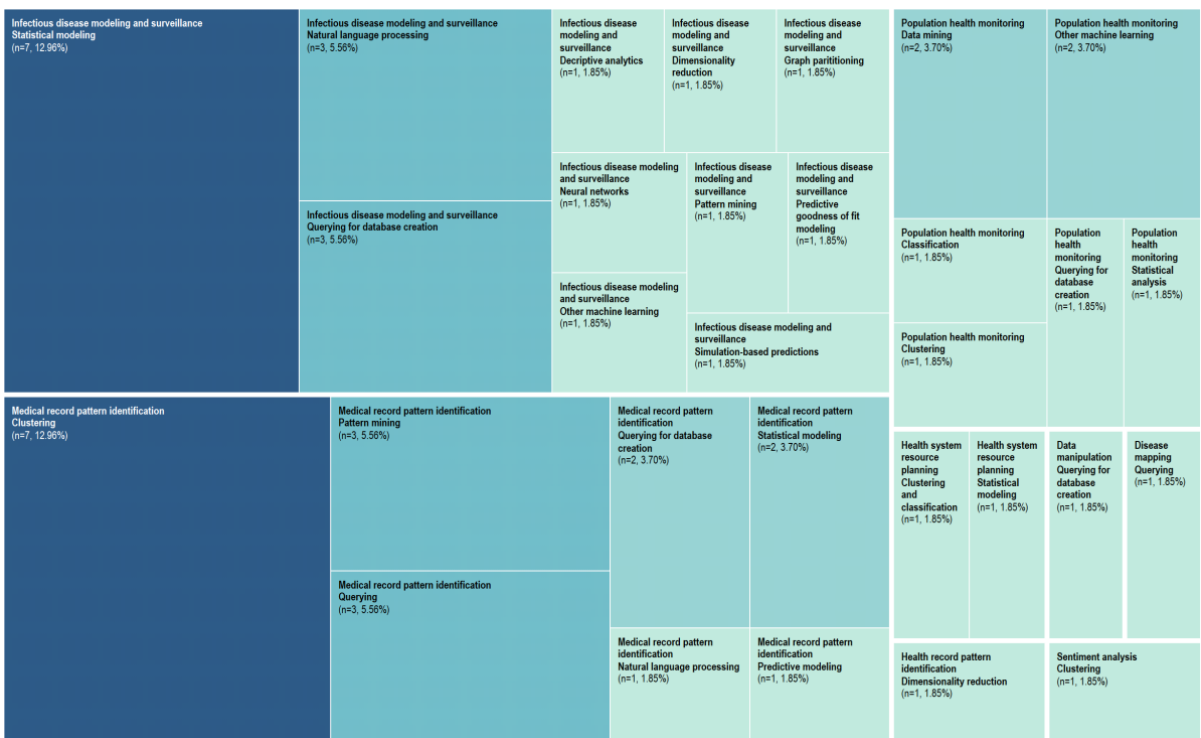
Figure 6. Problem categories and proportional distribution of analytic methods